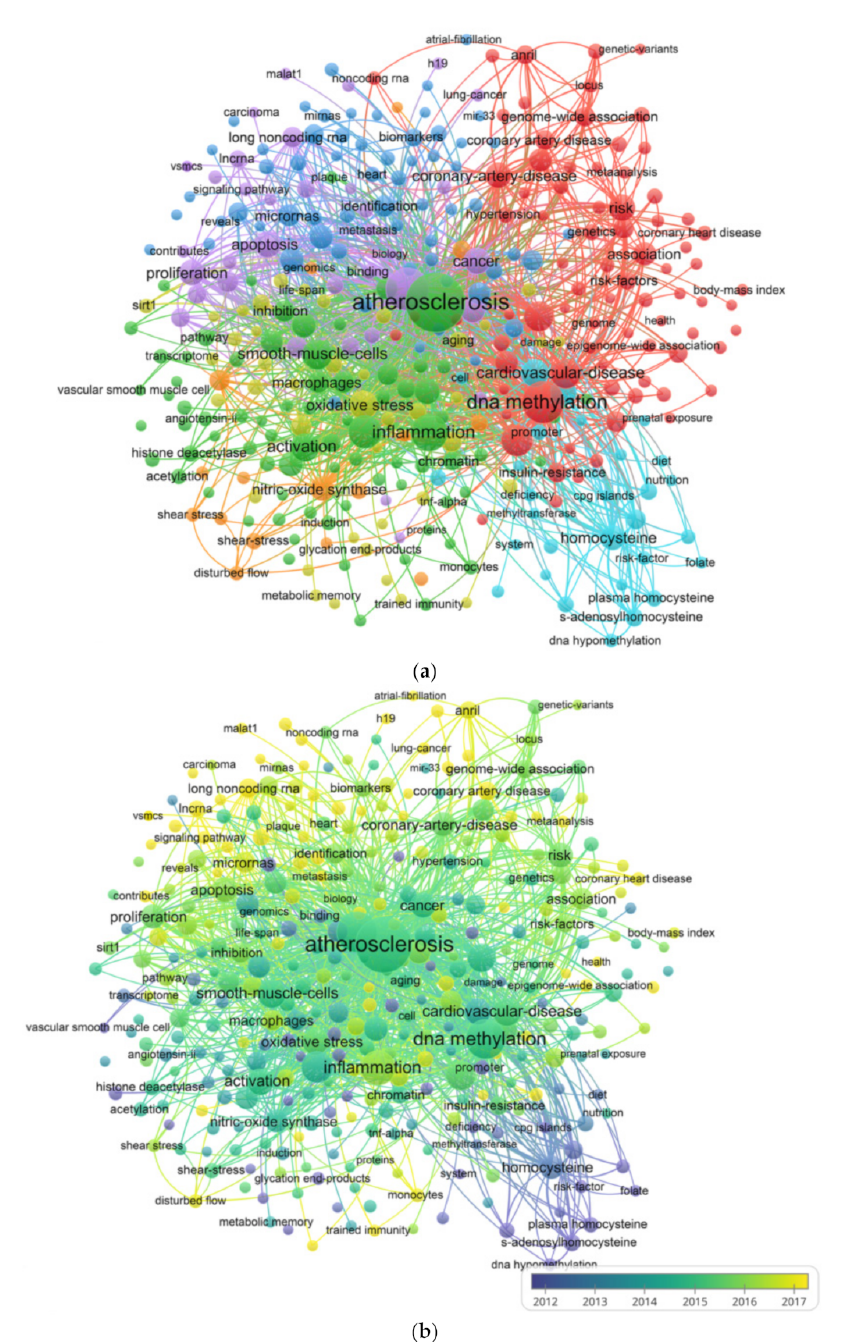
Figure 4. Co-occurrence analysis of global research about atherosclerosis. ( a ) Mapping of keywords in the research on atherosclerosis. The size of the points represents the frequency, and the keywords are divided into four clusters: molecular level research (left in blue), in vitro research (lower in yellow), in vivo research (right in red) and mechanism research (upper in green). ( b ) Distribution of keywords according to the mean frequency of appearance. Keywords in purple appeared earlier than those in green, and yellow keywords appeared later. The size of the points represents the citation frequency. A line between two points means that both were cited in one journal. A shorter line indicates a closer link between two journals. Points in the same color belong to the same research